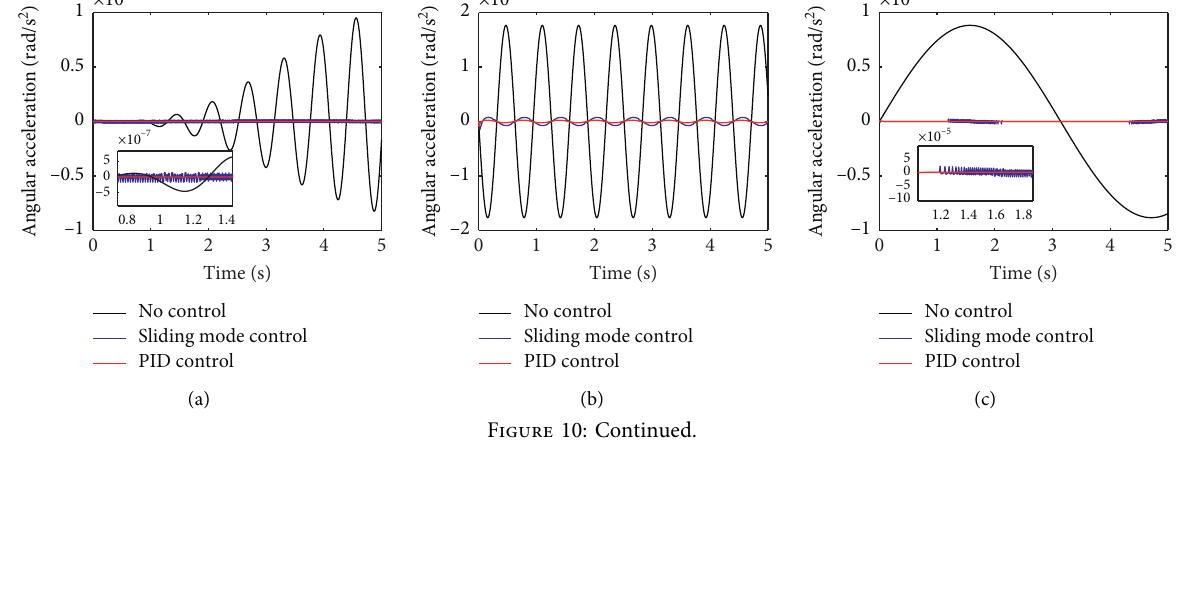
x , (e) y , and (f) z . x , (b) θ y , (c) θ z , (d)